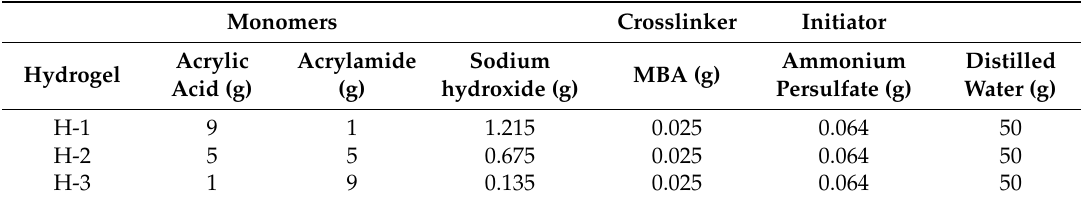
Table 1. Compositions of the hydrogels used in the